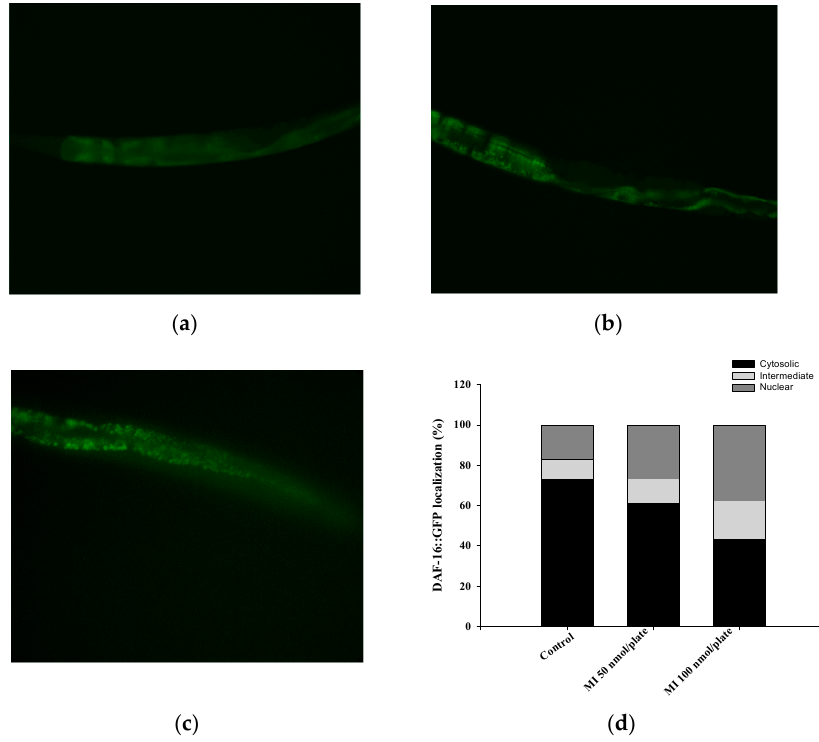
Figure 5. Effects the myo-inositol (MI) on the DAF-16 nuclear localization. After the MQD1543 strain of nematodes was grown on plates with different dosages of MI (0, 50 and 100 nmol/plate) for five days, the DAF-16:GFP fluorescence was measured as described in Methods. The representative photos at 200× magnification of ( a ) cytosolic localization, ( b ) intermediate localization, ( c ) nuclear localization, and ( d ) the semi-quantitative results of the DAF-16 distribution are shown. The data are from three independent experiments using 30 nematodes per group.